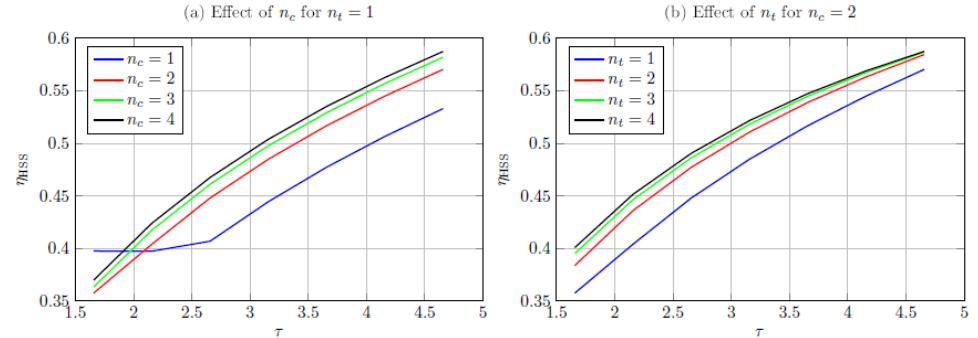
Figure 6. Hybrid storage system with regeneration, intercooled compression, and reheated expansion.